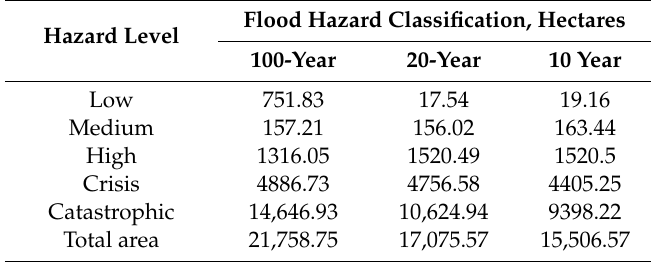
Figure 13. Flood hazard maps generated for the territory of the village Arnasay for different flood events. Left-100 year event, middle- 20 year flood event, right- 10 year flood event.